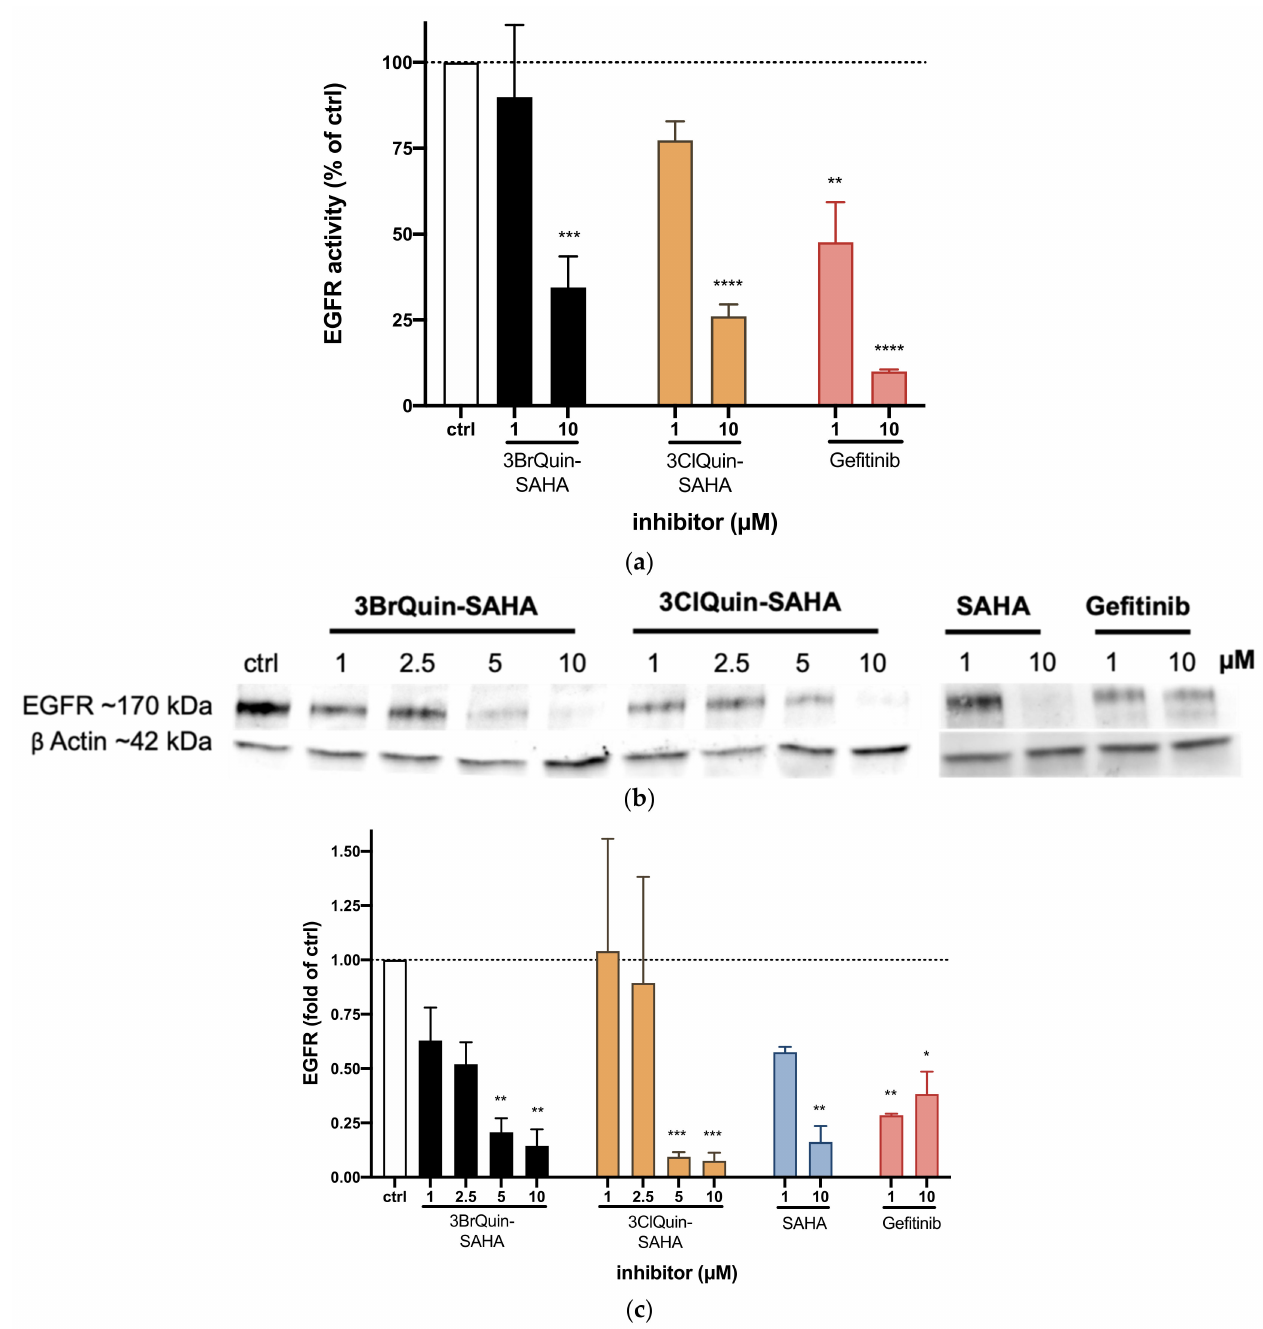
Figure 3. Inhibitory effects of 3BrQuin-SAHA and 3ClQuin-SAHA on EGFR tyrosine kinase activity and protein expression. ( a ) Dose-dependent inhibition of EGFR kinase activity by the novel chimeric inhibitors and gefitinib was determined in a cell-free EGFR-kinase assay. Means ± SEM of three independent experiments showing the percentage inhibition of treated vs. untreated controls whose kinase activity was set to 100%. ( b ) Representative Western blots of n = 3 independent experiments showing treatment induced changes in the expression of EGFR in DU145 cells after 24 h. ß-actin was used as loading control. ( c ) Out of these Western blots’ gray intensity, mean ± SEM of EGFRs’ specific bands were quantified and adjusted to protein-loading and normalized to untreated control. * p ≤ 0.05, ** p ≤ 0.005, *** p ≤ 0.0005, **** p ≤ 0.0001; two-way ANOVA Dunnett’s post hoc